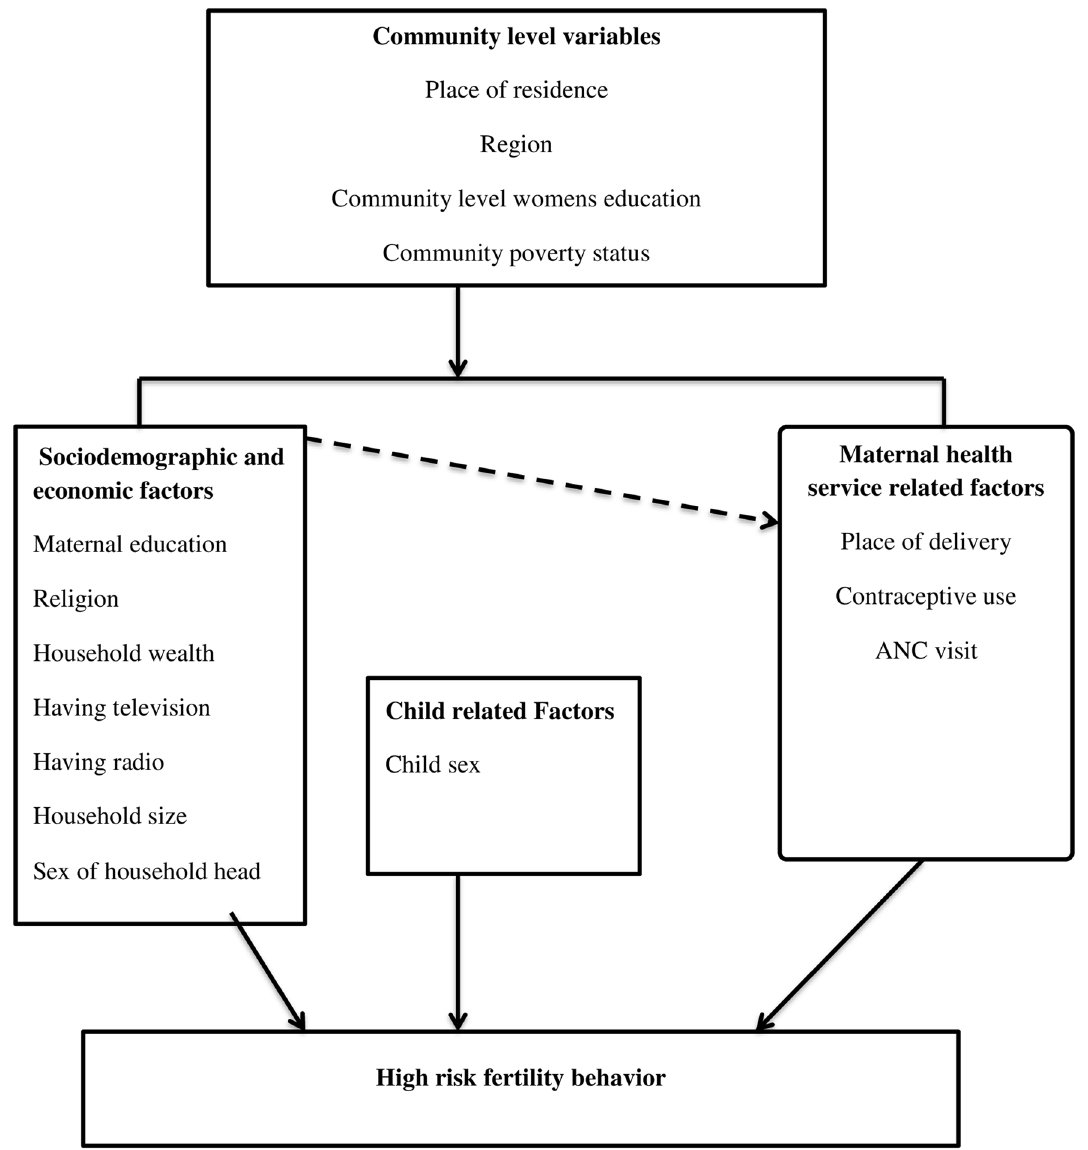
Fig. 1 Conceptual framework of factors associated with high-risk fertility behavior developed from searching of